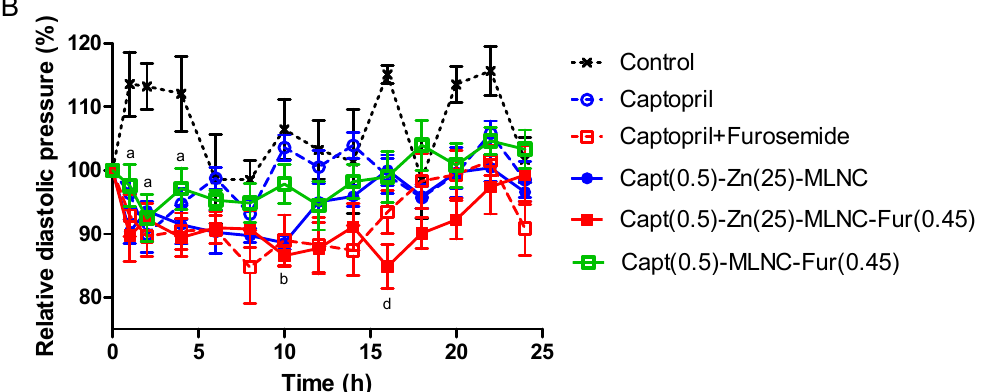
Figure 2. Systolic blood pressure ( A ) and diastolic blood pressure ( B ) (% from the basal pressure) from the first day of administration of solutions or formulations (8 mL kg −1 ) by indirect tail method ( n = 6). Data are represented as means ± standard error of the mean. a Significantly different from control; b significantly different from captopril; c significantly different from captopril + furosemide; d significantly different from Capt(0.5)-Zn(25)-MLNC (two-way ANOVA/Bonferroni; p < 0.05).